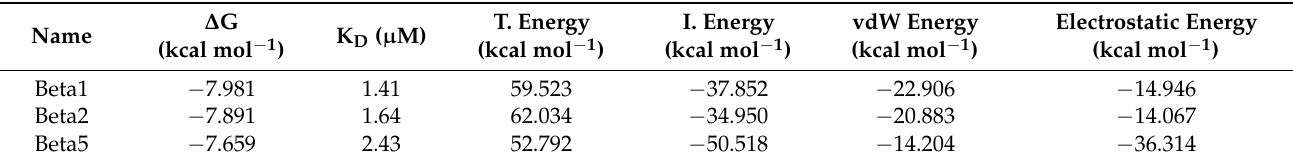
Table 2. Predicted affinities and energy contribution values for the complexes formed between human constitutive 20S proteasome catalytic subunits and amygdalin. I. Energy: Internal energy term consists of torsional energy, repulsion at short distances, van der Waals and electrostatic contributions. T. Energy: total energy term consists of Internal energy + electrostatic and van der Waals contributions to the intermolecular